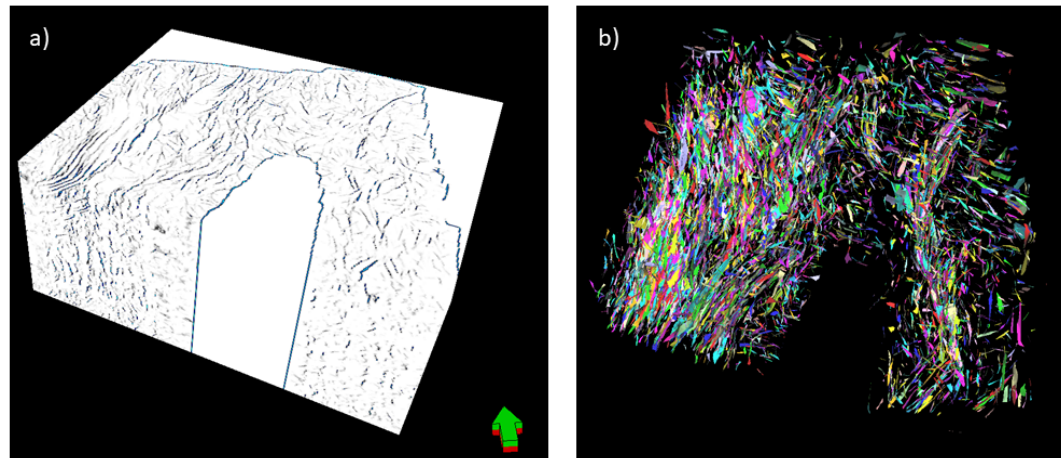
Figure 8. ( a ) The Ant-tracking results for the whole 3D seismic volume including the La Florida anticline (left side) and the Cusiana fault footwall block (right side). ( b ) The fault patches volume shows a greater fracture intensity in the folded Cusiana hanging wall than in the footwall.